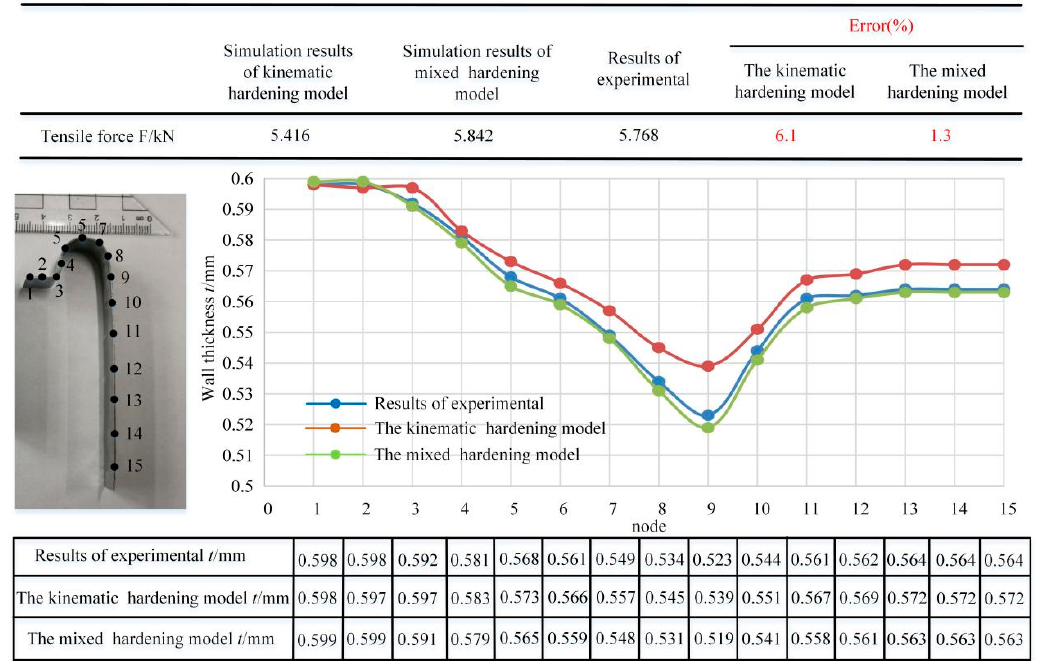
Figure 14. Comparison between FEM results and experimental results.